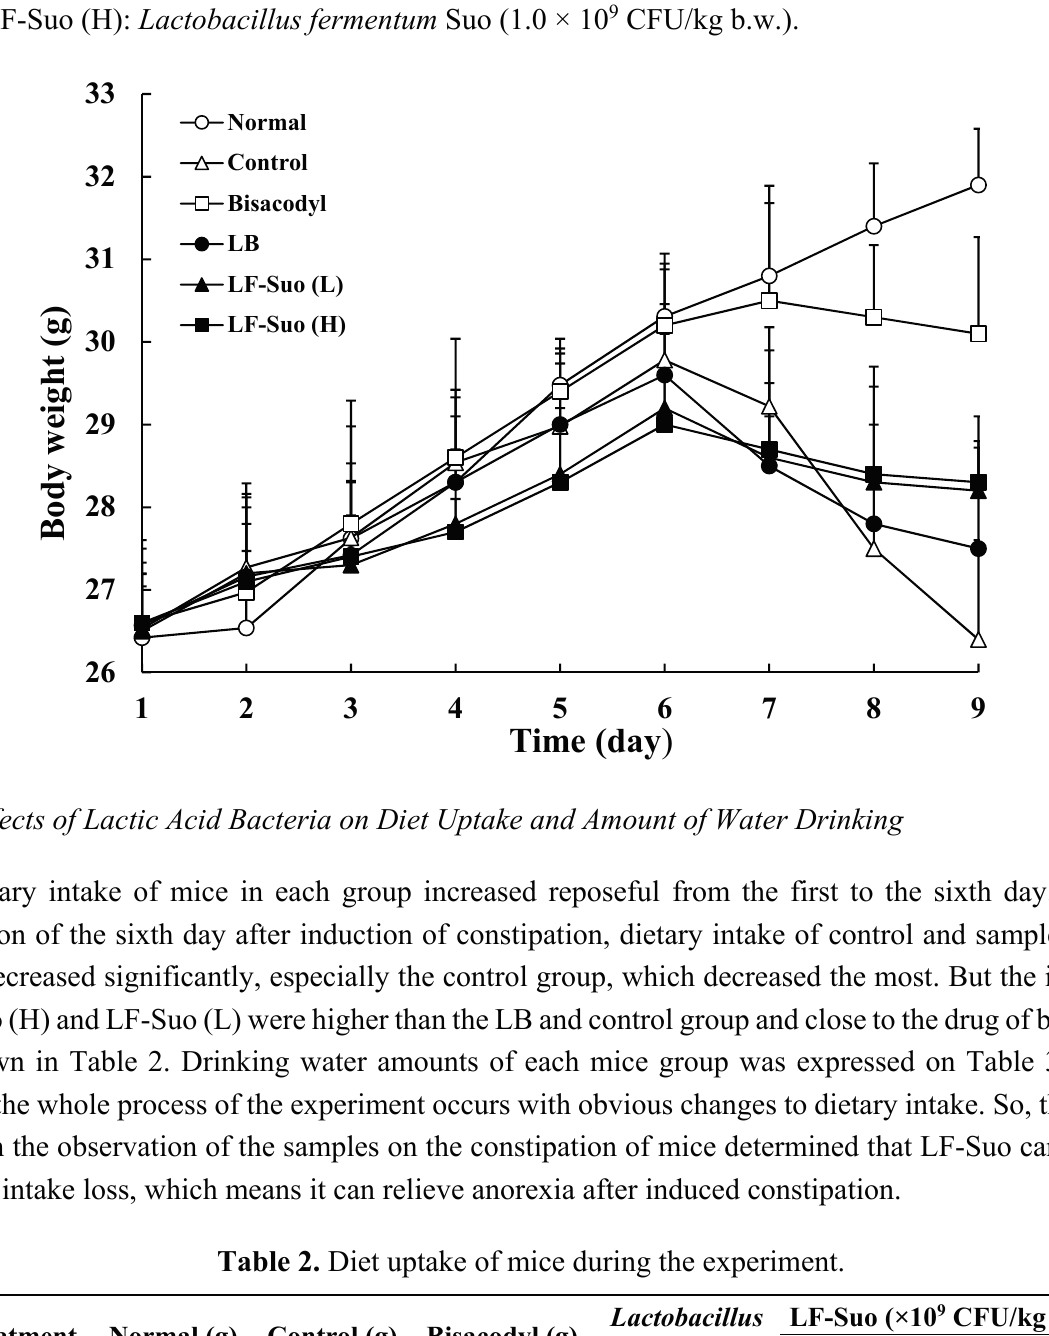
Figure 1. Body weight of mice during the experiment. n = 10 ICR (Institute of Cancer Research) mice in each group, bisacodyl: 100 mg/kg b.w. (body weight); LB: Lactobacillus bulgaricus (1.0 × 10 9 CFU/kg b.w.); LF-Suo (L): Lactobacillus fermentum Suo (1.5 × 10 9 CFU/kg b.w.); LF-Suo (H): Lactobacillus fermentum Suo (1.0 × 10 9 CFU/kg b.w.).